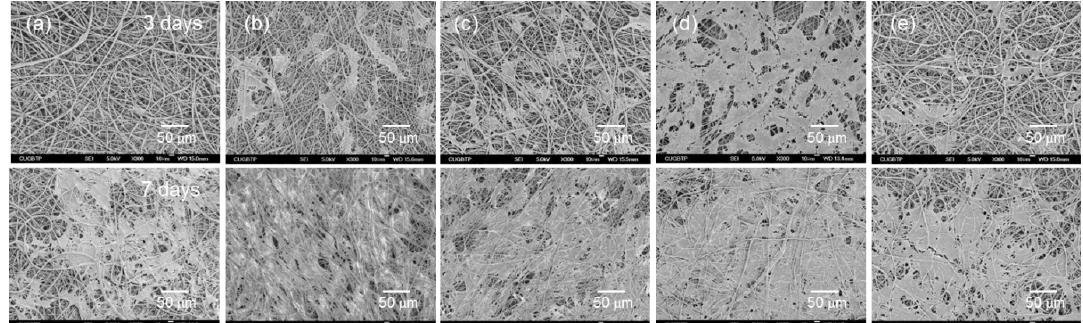
Figure 9. Morphologies of MC3T3-E1 cells on ( a ) PVDF, ( b ) PE02, ( c ) PE04, ( d ) PE06, and ( e ) PO06 composite nanofibers after culturing for 3 and 7 days.